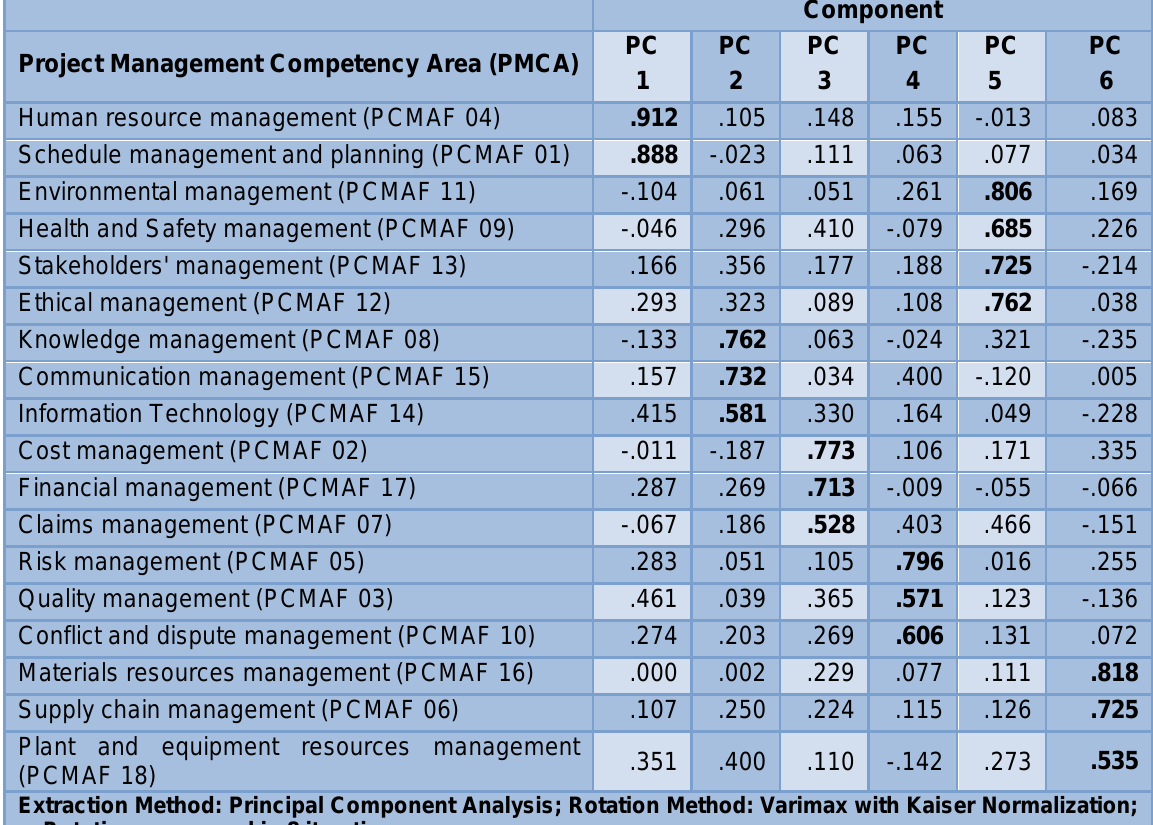
Table 4: Rotated Component Matrix Discussion of